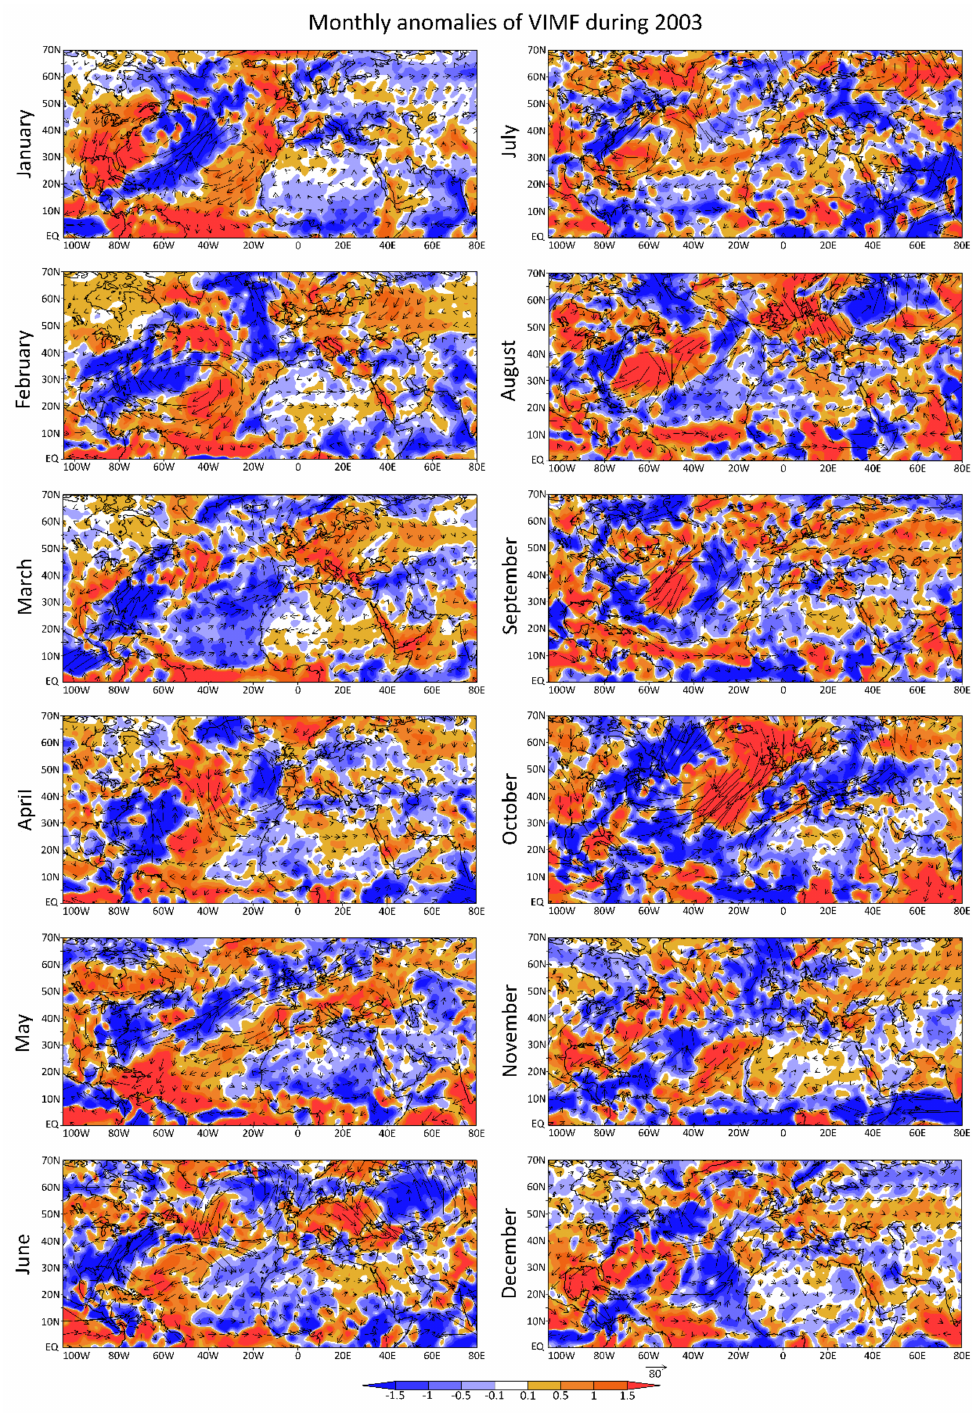
Figure 6. Monthly anomalies of the ERA-Interim vertically integrated moisture flux (VIMF) (vector, kg/(m/s)) and its divergence (shaded, mm/day) in